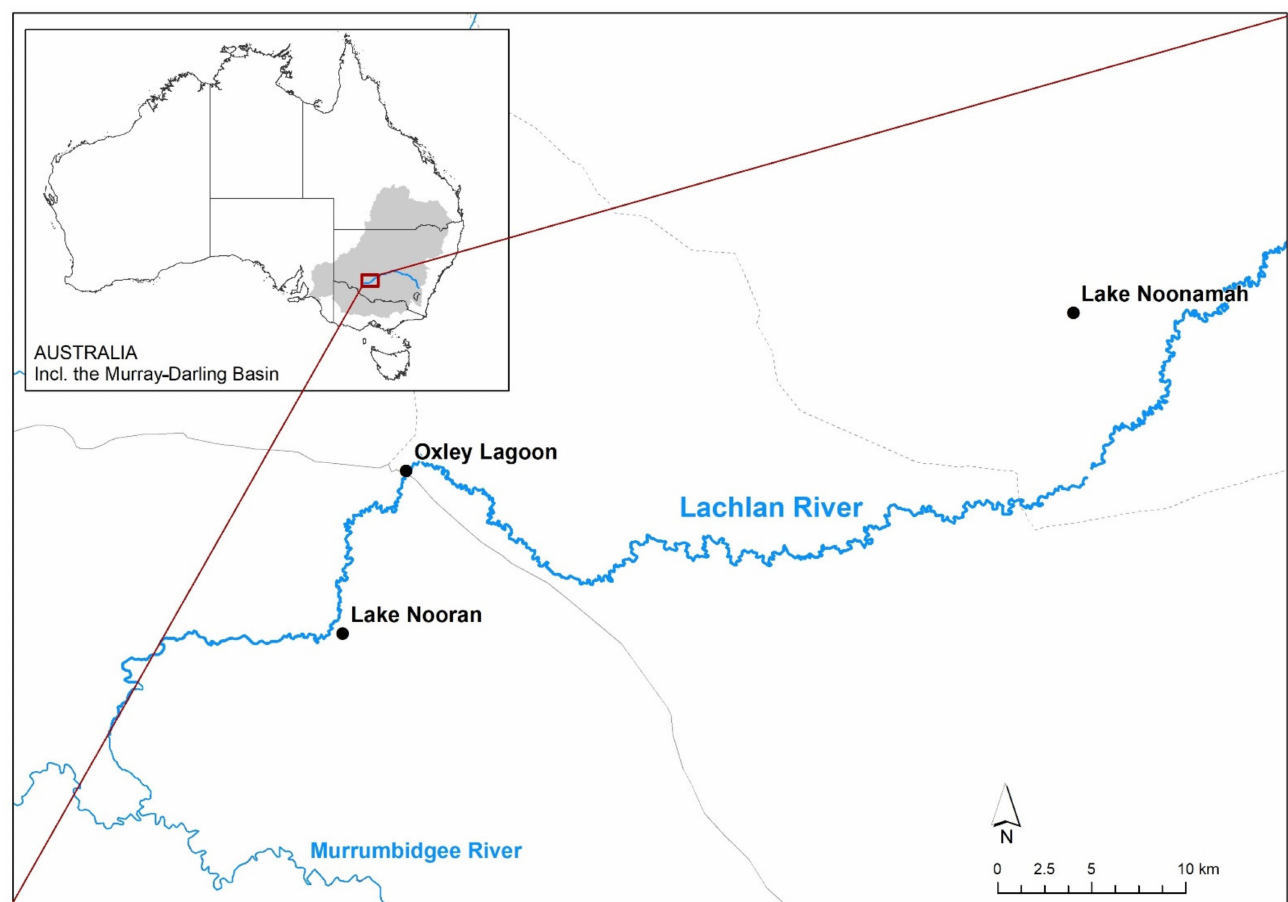
Figure 1. The floodplain wetland sites used in this study, where Eleocharis acuta and Marsilea drummondii samples were collected from within 2–3 patches in each wetland. The inset shows the location of the Lachlan River (in blue) and the Murray–Darling Basin (shaded light grey) in